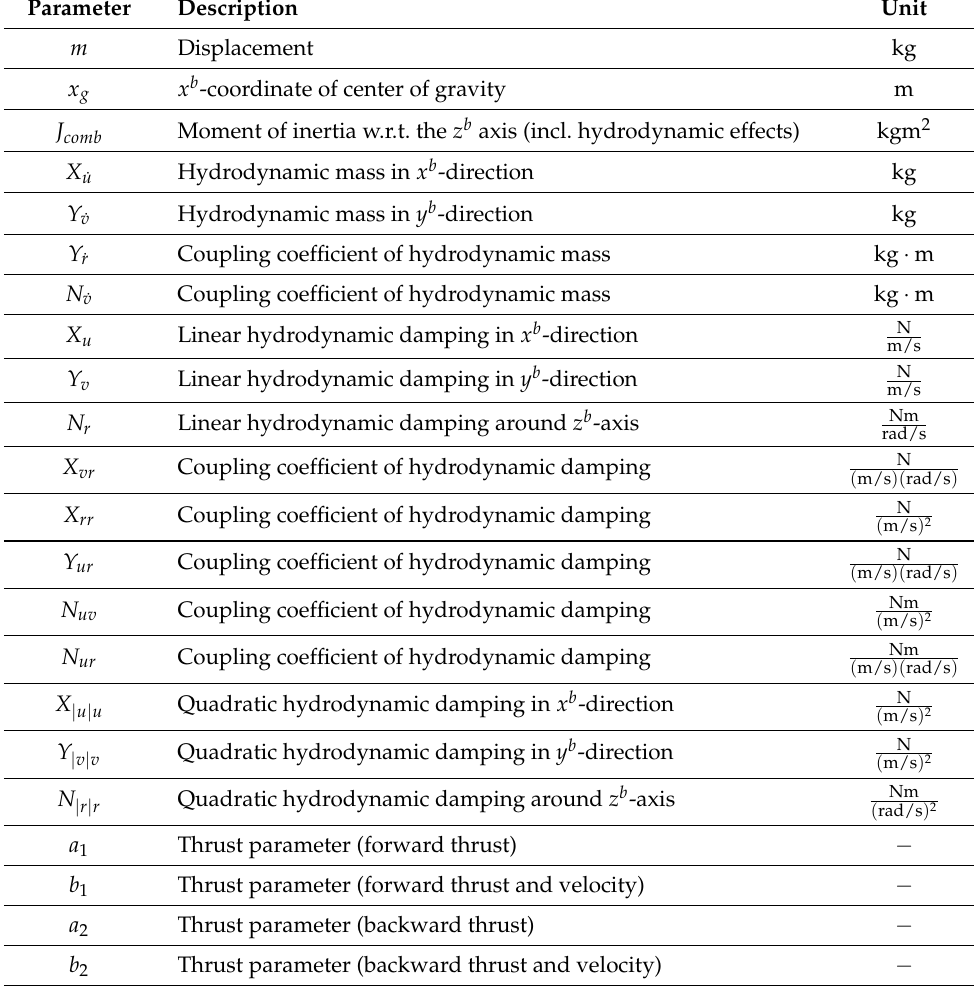
m/s m/s rad/s ( m/s )( rad/s )